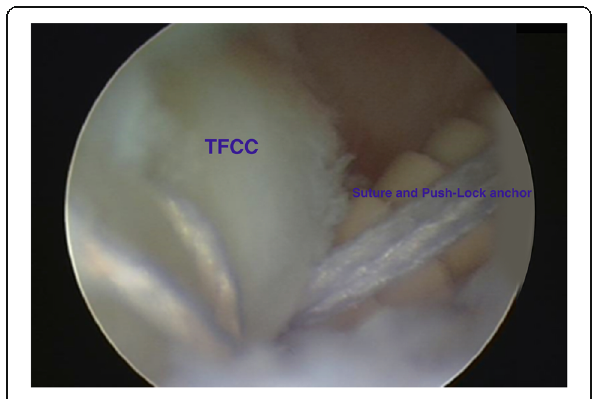
Fig. 3 Arthroscopic re-insertion of the TFCC with push-lock suture anchor (Arthrex®). Right